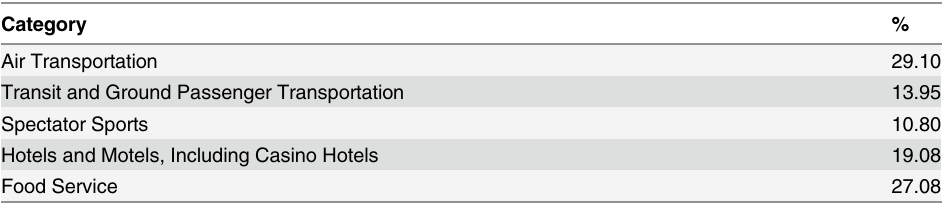
Table 1. Allocation of Travel Expenditure by Category